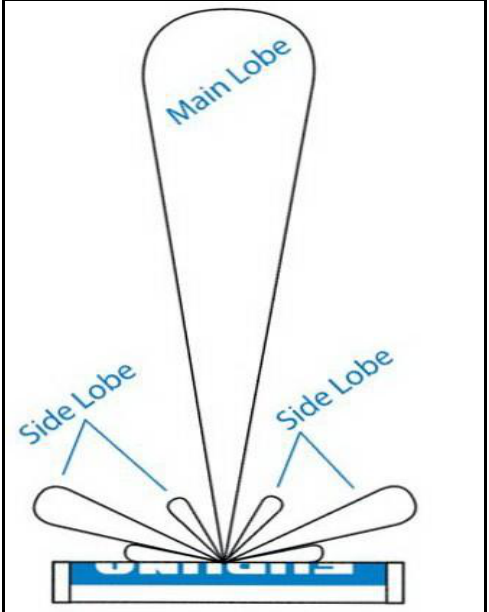
для т - образной антенны